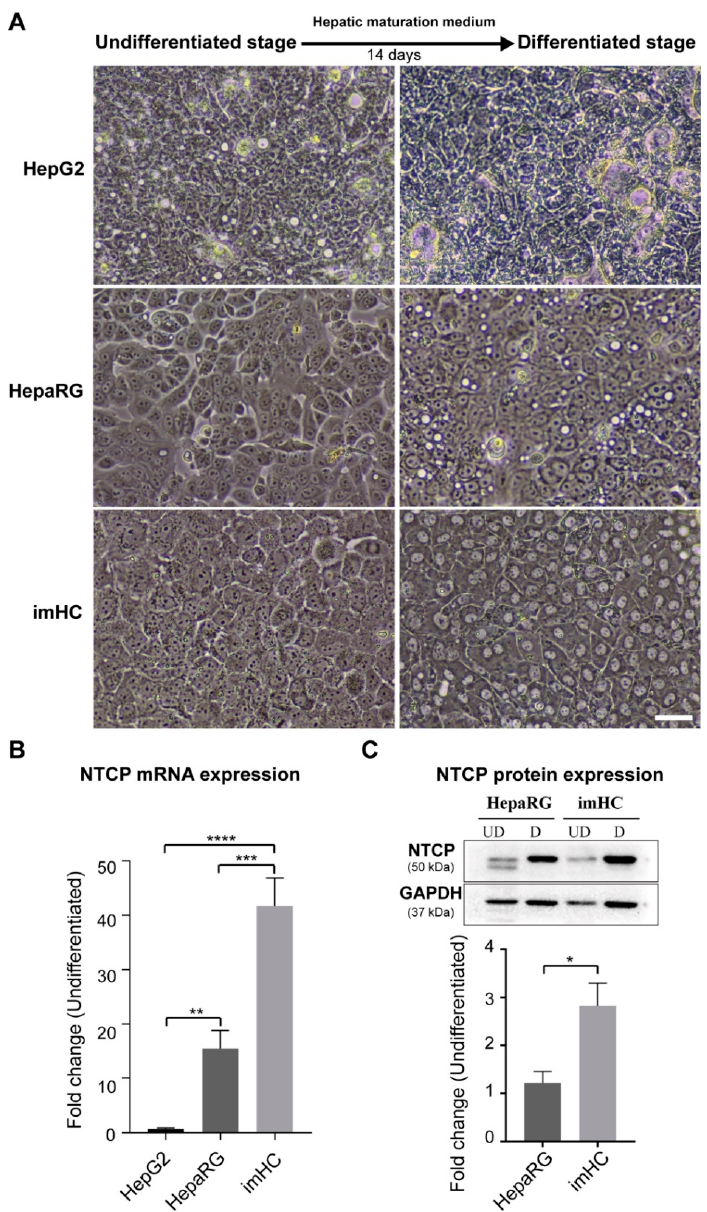
Figure 2. Induction of hepatic maturation of imHC and NTCP characterization in mature cells. The imHC, HepaRG and HepG2 were maintained in hepatic maturation medium for two weeks. Hepatic architectures, such as a cord-like structure, bi-nucleated and polygonal-shaped morphology, signified exclusively the di ff erentiated stage of imHCs ( A ). The scale bars represented 50 µ m. After maturation induction, NTCP expression was significantly increased in both imHC and HepaRG ( B ). The level of NTCP protein after normalization with GAPDH was higher in imHC than in HepaRG ( C ). Data are presented as mean ± SD. *, **, *** and **** represented statistical di ff erent data with a p -value < 0.05, < 0.01, < 0.001 and < 0.0001